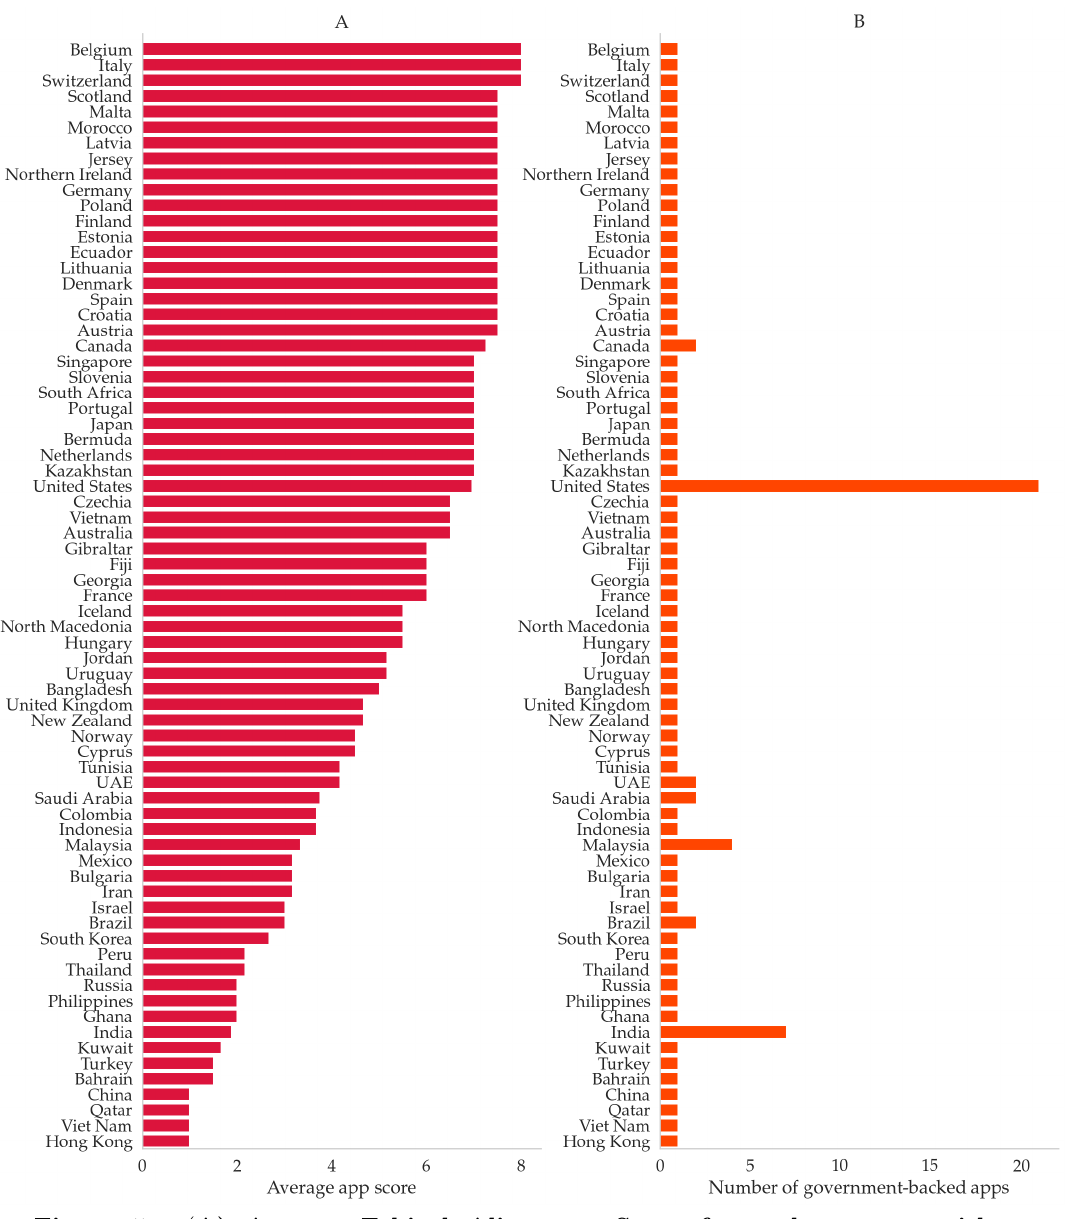
Figure 5. ( A) Average Ethical Alignment Score for each country with a government-backed app. (B) Number of government-backed apps per coun- try. Countries whose apps conform most closely with principles of ethical digital contact tracing include Switzerland, Italy, and Belgium. Countries/Territories with the lowest aver- age score include Hong Kong, Viet Nam, Qatar, and China. The United States and India far outpace other countries in terms of how many government-backed apps have been released. an influx of new applications, predominantly from North America and Europe, during the